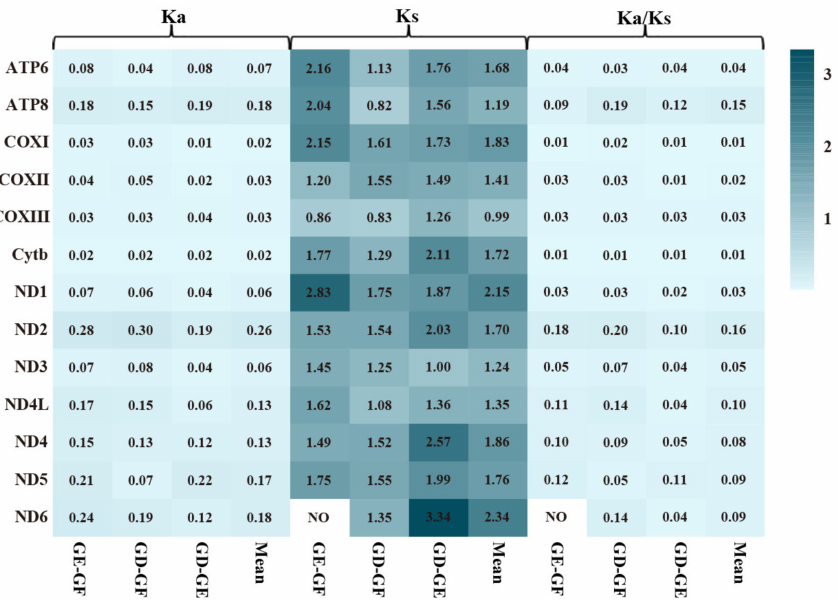
Figure5. Thepairgeneticdistancesof13PCGsbetween G.filamentosus , G.erythrourus, and G.decacanthus . The values were calculated based on the first and second nucleotide position, and on the third nucleotide position, respectively.